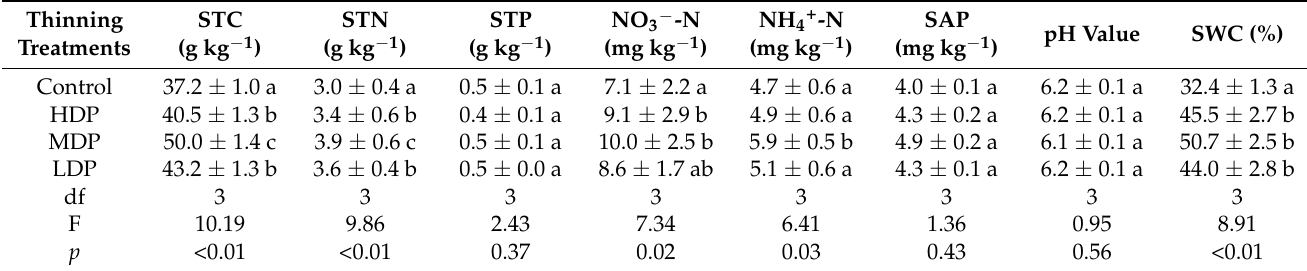
Table 1. Soil properties under different density adjustment in L. principis-rupprechtii plantations. Thinning